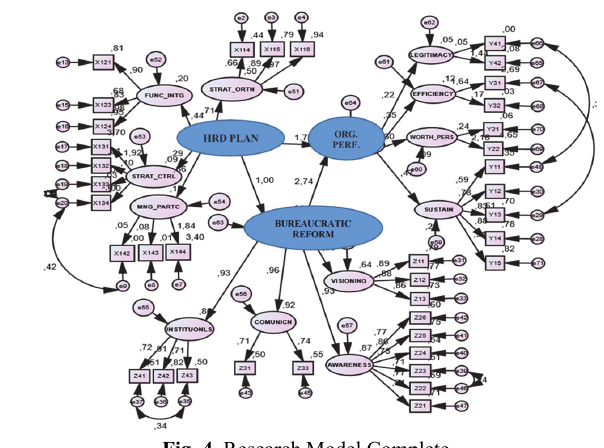
Fig. 4. Research Model